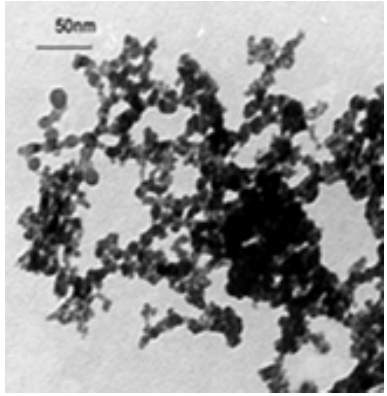
Fig. 1. TEM image of Fe